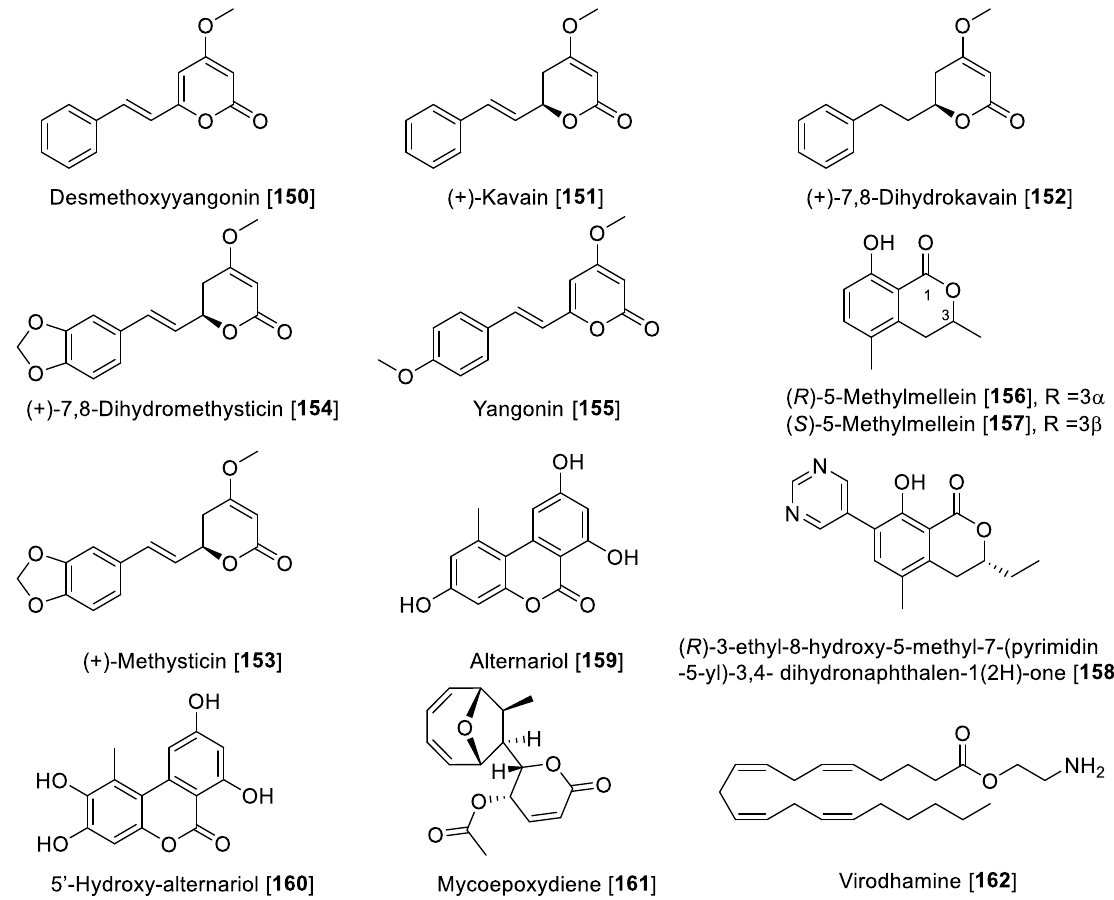
Figure 15. Chemical structure of selected miscellaneous compound MAO inhibitors. Table 7. Terpenoids, marine sources, and miscellaneous natural product inhibitors of MAO-A and MAO-B.